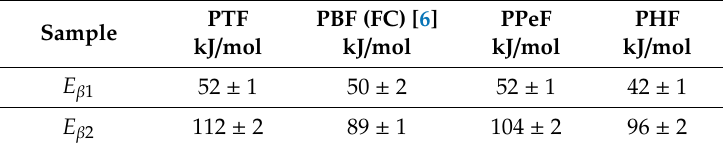
Table 2. Activation energies (E) of local relaxation processes for poly(alkylene furanoate)s.